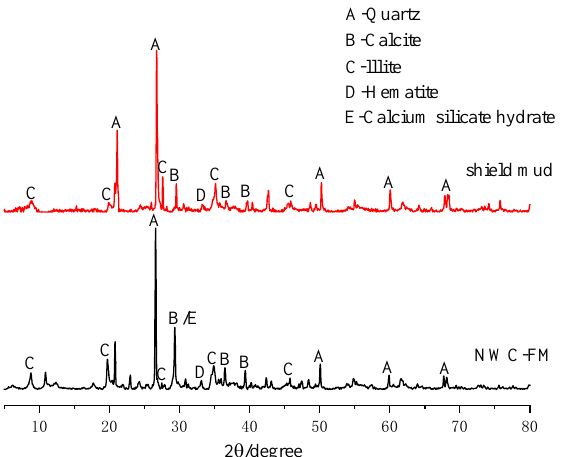
Figure 8. XRD diagram of undisturbed shield mud and consolidated body of NUC-FM.